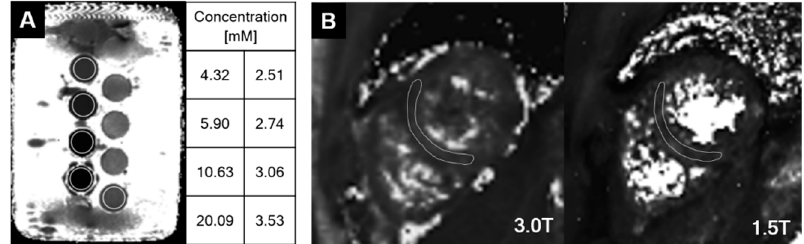
Figure 1. T2* maps in a phantom ( A ) and normal myocardium ( B